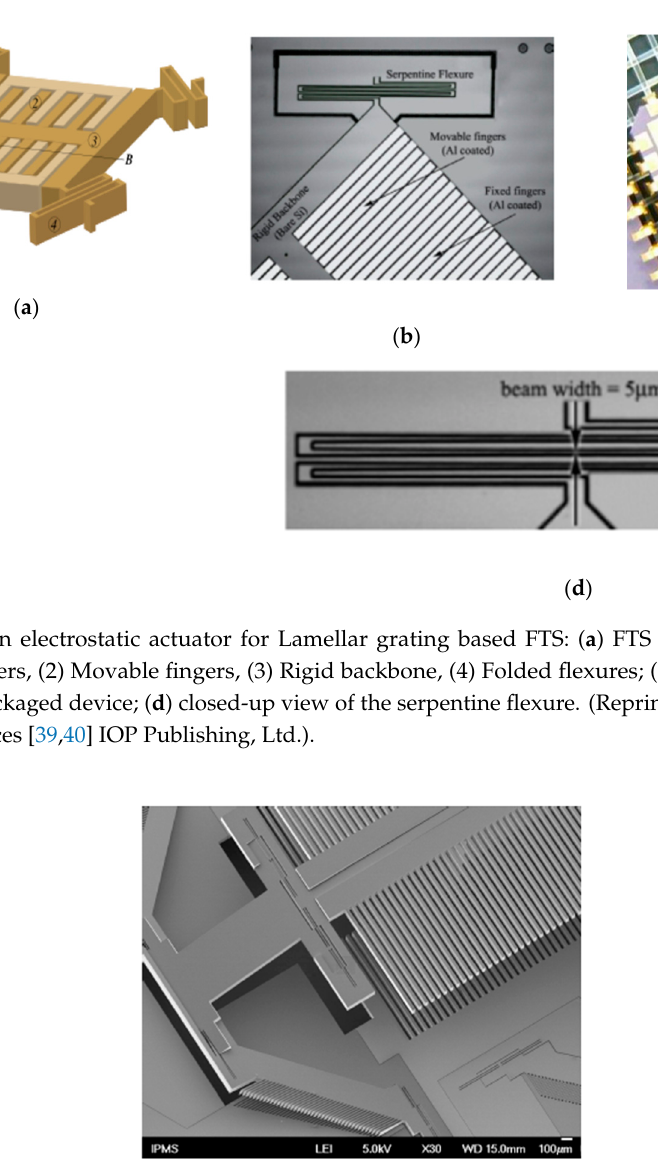
Figure 17. SEM picture of the fabricated deflected device. (Reprinted with permission from Reference [41] IEEE).